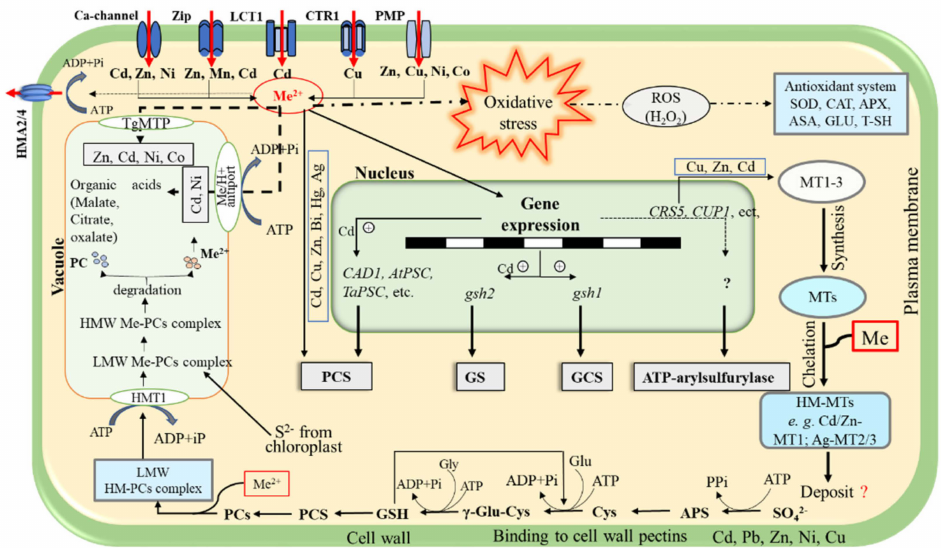
Figure 2. Schematic representation of various mechanisms involved in plant metal detoxification. ZIP, LCT1, and CTR1: metal transporters at the plasma membrane; HMA2/4: metal transporters; TgMTP and HMT: metal transporters at the tonoplast; Me 2+ : bivalent metals; ROS: reactive oxygen species; H 2 O 2 : hydrogen peroxide; SOD: superoxide dismutase; CAT: catalase; APX: ascorbate peroxidase; ASA: ascorbic acid; GLU: glutathione; T-SH: protein thiols; PCS: phytochelatin synthase; GS: glutathione synthetase; GCS: γ -glutamylcysteine synthetase; APS: adenosine 5’-phosphosulfate; Cys: cysteine; Glu: glutamate; GSH: glutathione; MT: metallothionein; LMW: low molecular weight; HMW: high molecular